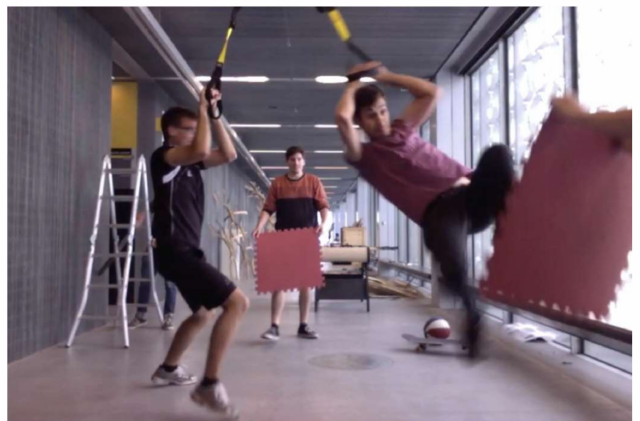
Figure 1. A screenshot from the HangXRT video recordings. Two players holding onto the TRX fitness equipment. One of them is up in the air swinging to hit a Styrofoam mat. Two researchers are holding mats in the air as targets for the